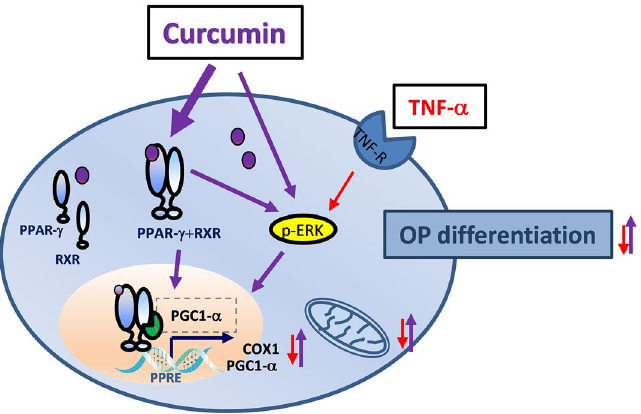
Figure 6. Graphical representation of curcumin effects on